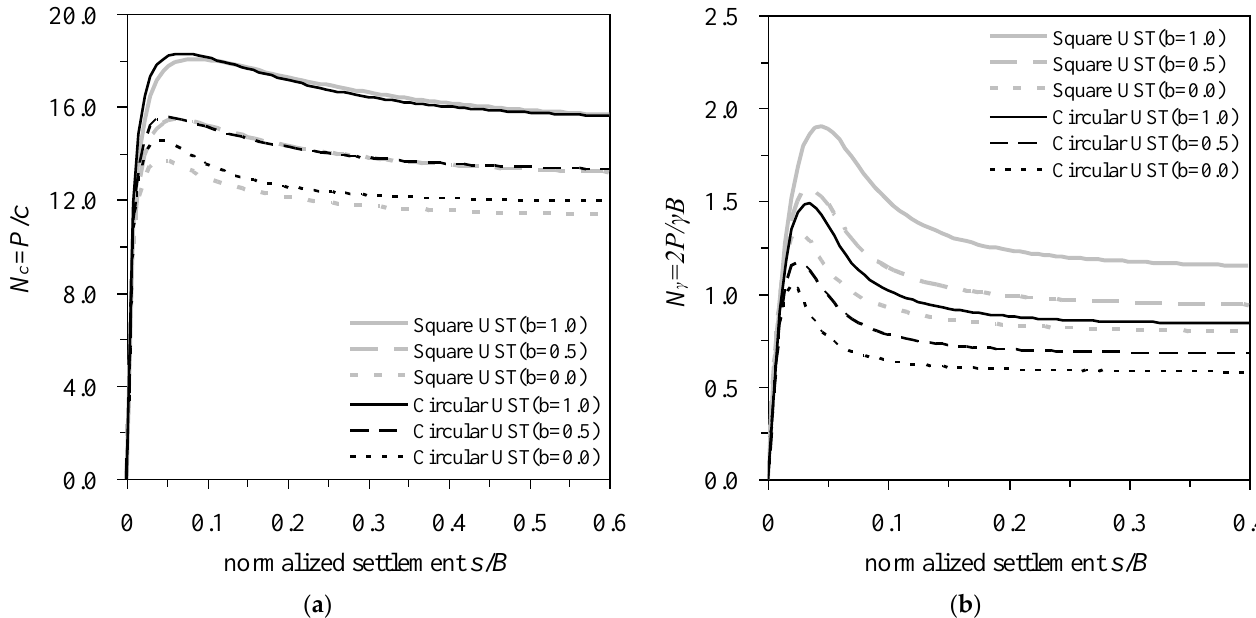
Figure 6. Relationship between bearing capacity factors and vertical displacement: ( a ) N c , ( b ) N γ .